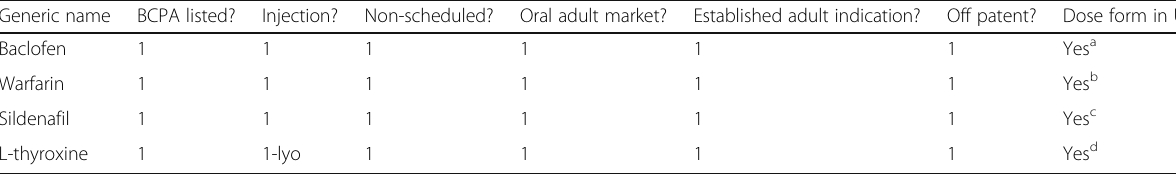
Table 1 M4KRC fourth tier candidate API